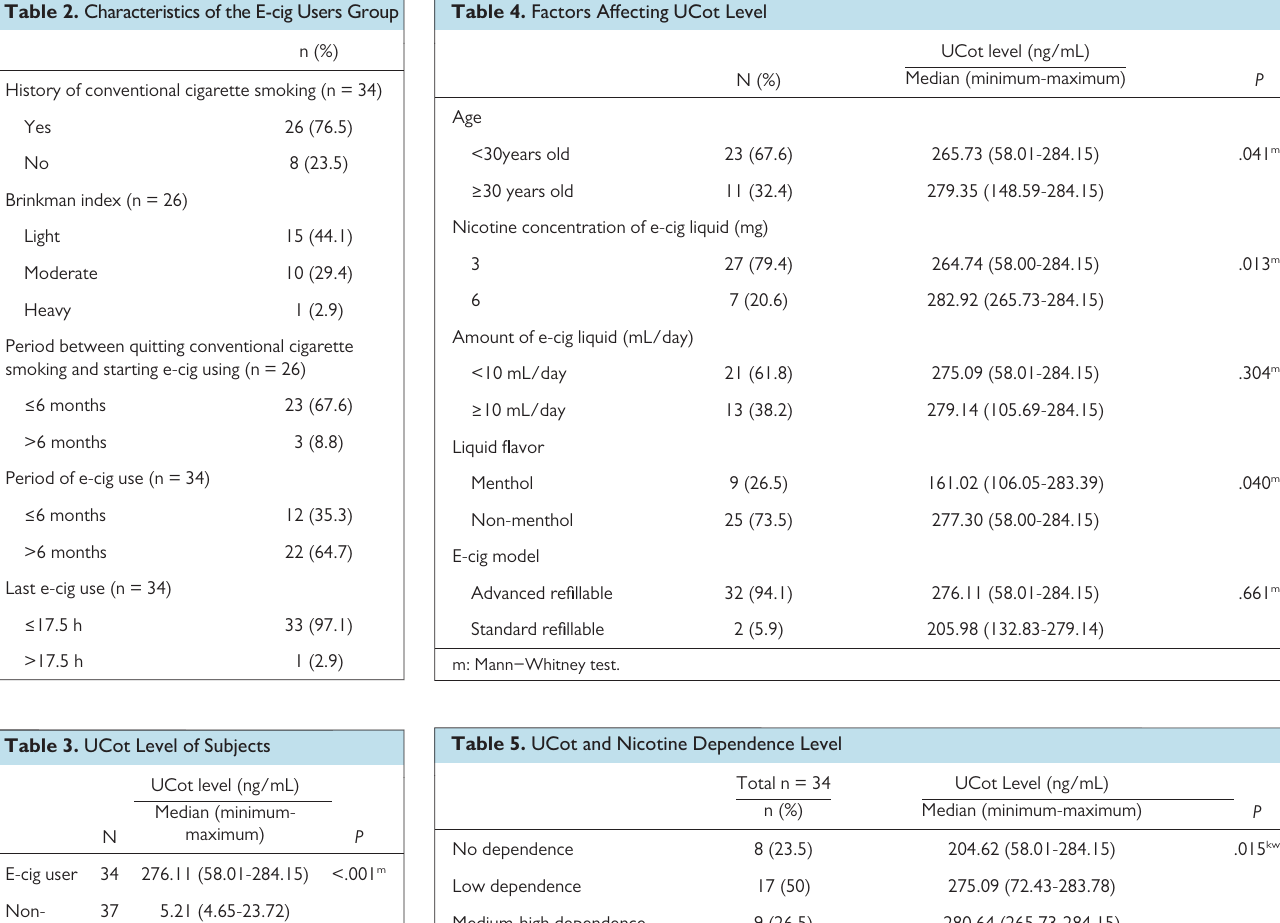
Table 4. Factors A ff ecting UCot Level